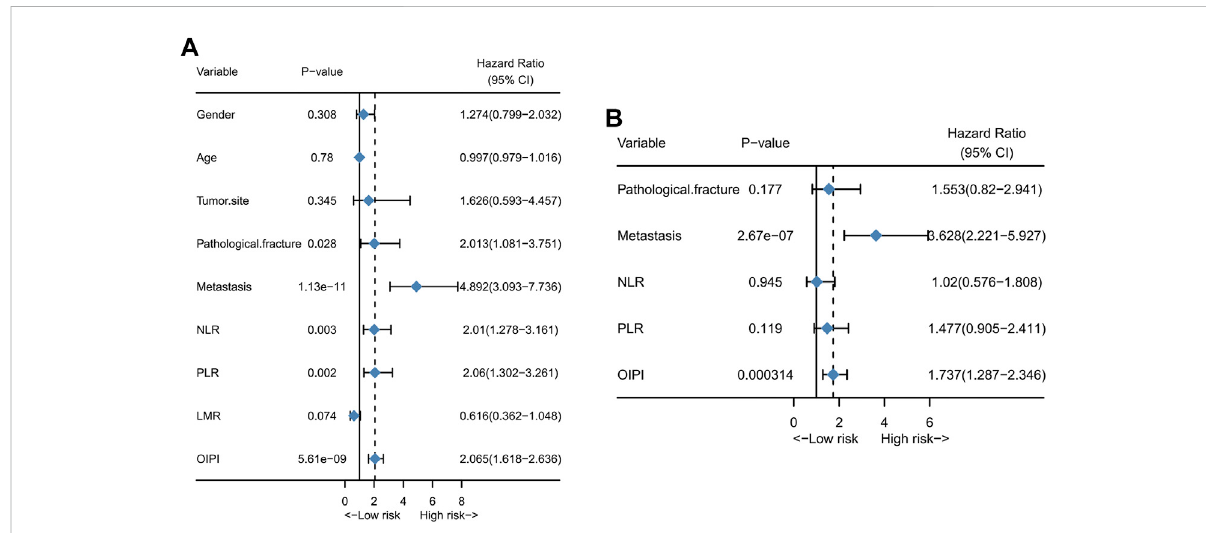
FIGURE 4 Independent risk factors of OS in 223 osteosarcoma patients. (A) Univariate analysis of clinical characters and in fl ammatory biomarkers. (B) Multivariate analysis of signi fi cant clinical characters and in fl ammatory biomarkers in univariate analysis to determinate independent prognostic factors. NLR; neutrophil – lymphocyte ratio; PLR, platelet – lymphocyte ratio; LMR, lymphocyte-monocyte ratio; OIPI, osteosarcoma immune prognostic index.